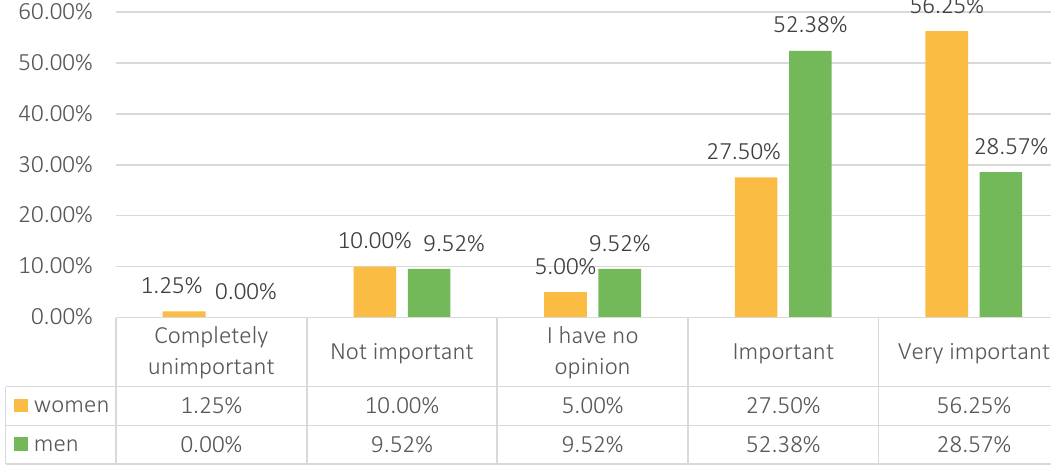
Figure 2. Importance of subordinates’ integrity values during the COVID-19 crisis